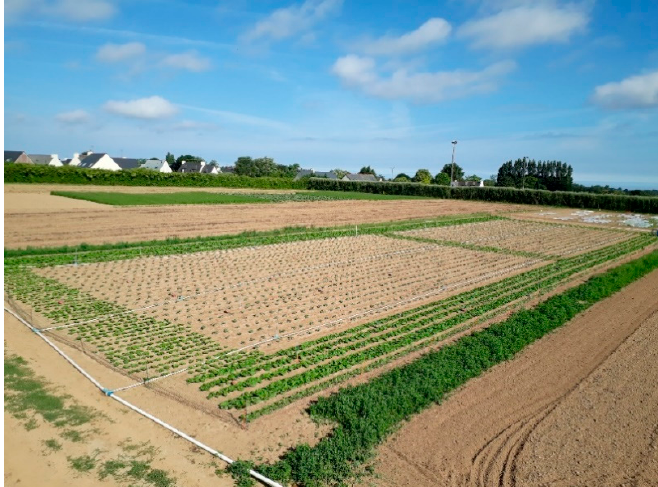
Figure 2. Field trial to evaluate a ‘push–pull strategy’ to manage Delia radicum in broccoli using Chinese cabbage (outer rows) as a trap crop [87] (image provided by Fabrice Lamy and Anne-Marie Cortesero, University of Rennes,